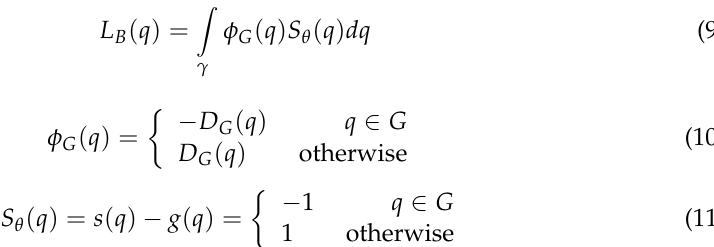
Figure 11. Schematic of the region integral of Dist ( ∂ G, ∂ S ).